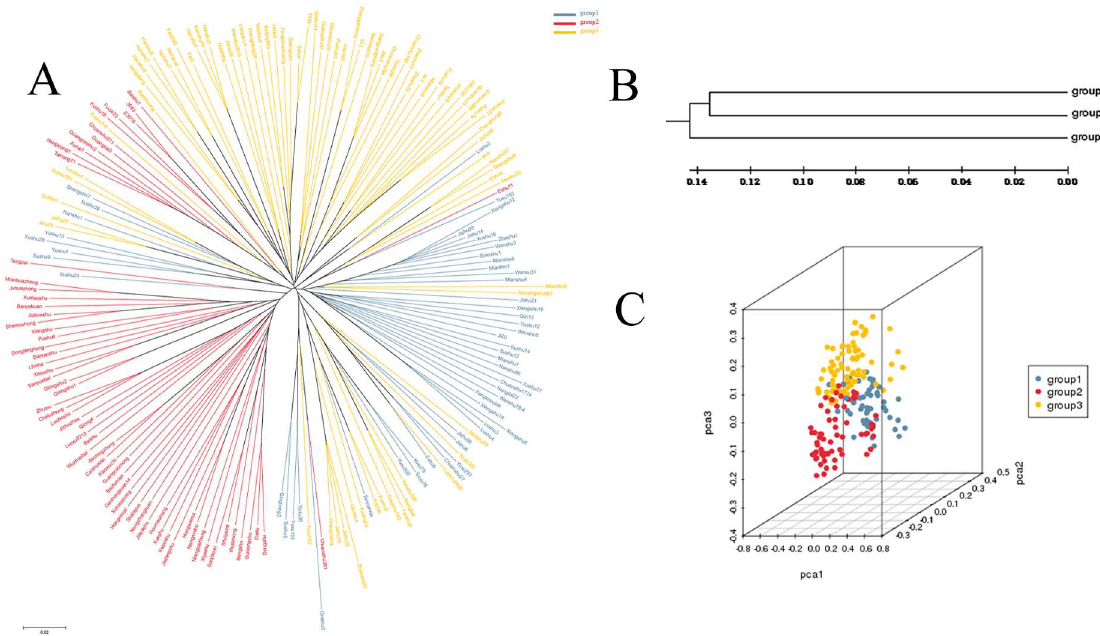
Fig 4. Characterization of the genetic structure of the 197 sweet potato accessions. (A) Phylogenetictree of the 197 accessions basedon the analysisof 62,363 SNPs. (B) UPGMA dendrogram basedon Nei’s distanceamongthree inferred groups. (C) PCA plot of the 197 accessionsbased on the analysisof 62,363 SNPs.